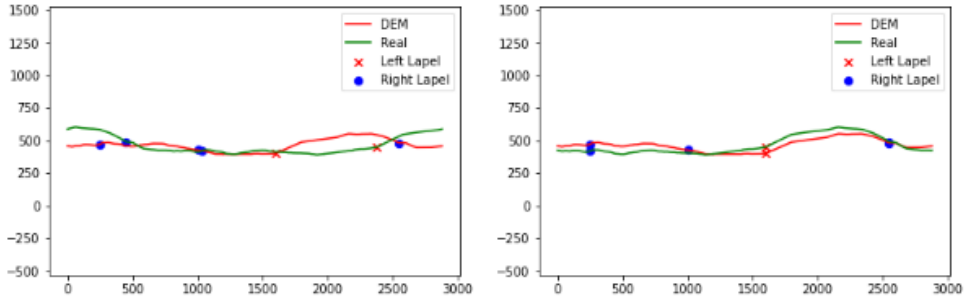
Figure 23. Coarse matching: ( Left ) the state before the DEM skyline is coarsely matched with the image skyline; and ( Right ) the state after coarse matching between DEM skyline and image skyline. Through the coarse matching, the candidate yaw in the image can be determined at the same